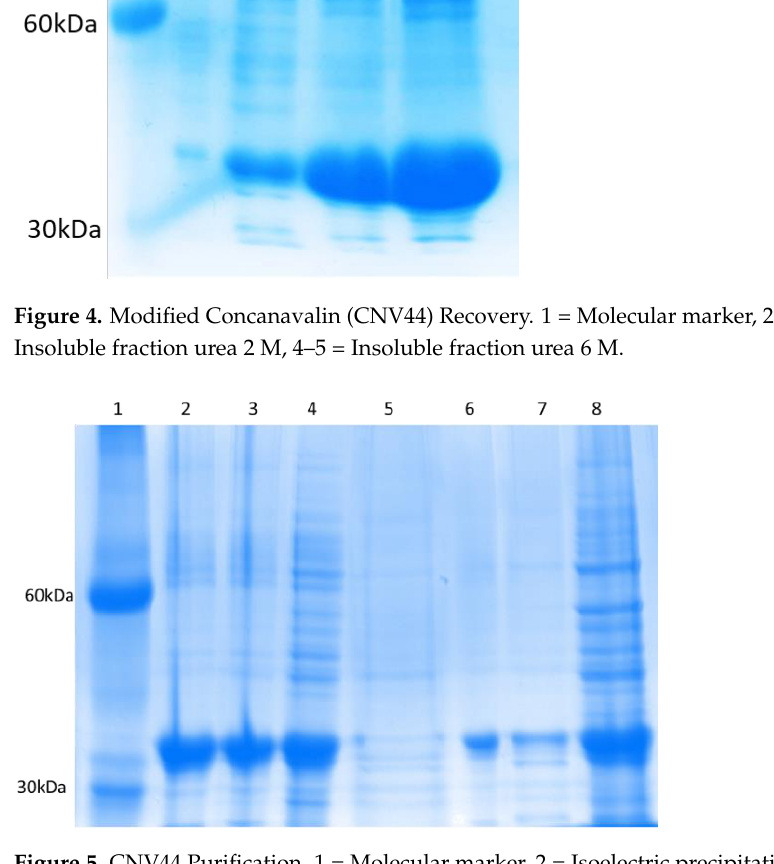
Figure 5. CNV44 Purification. 1 = Molecular marker, 2 = Isoelectric precipitation pH2, 3 = Isoelectric precipitation pH3, 4 = Isoelectric precipitation pH4, 5 = NaCl 1 M, 6 = 4% Ammonium sulfate, 7 = 6% ammonium sulfate, 8 = Starter pellet.